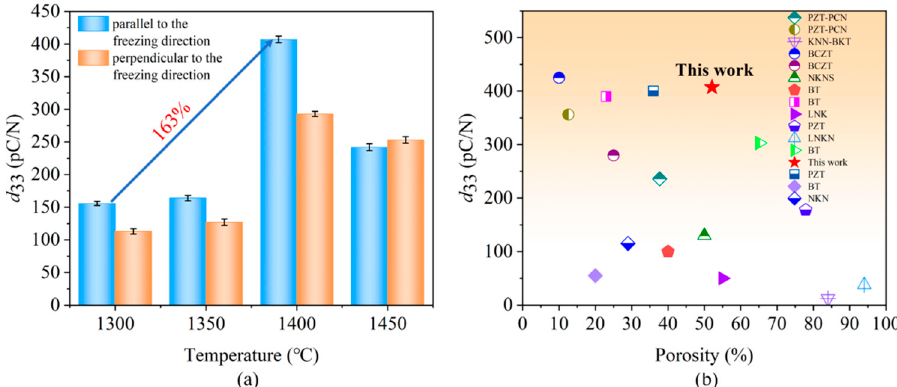
Figure 9. ( a ) Piezoelectric coefficient of porous BCZT piezoelectric ceramics sintered at different temperatures (parallel and perpendicular to the freezing direction), ( b ) comparison of the d 33 of porous BCZT piezoelectric ceramics with other porous piezoelectric materials. The other porous piezoelectric materials include LNK (porous lithium sodium potassium niobate ceramics) [7], NKN